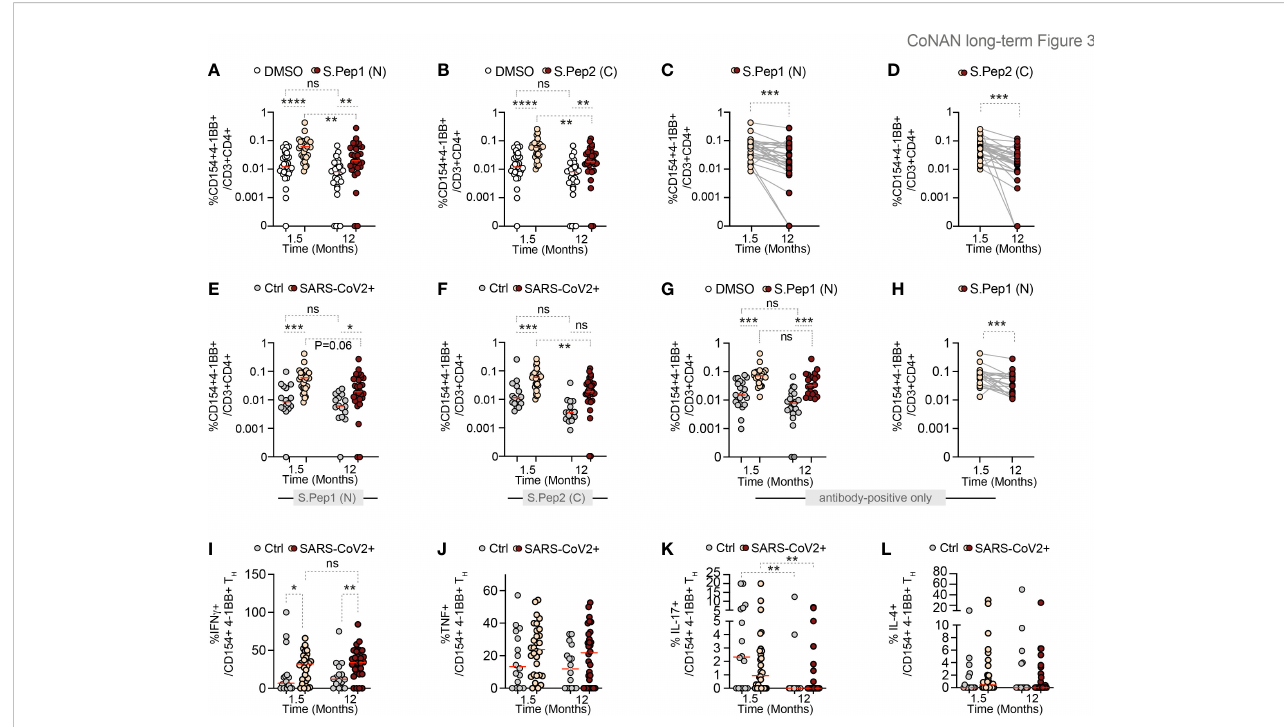
FIGURE 3 Longitudinal SARS-CoV-2 – speci fi c T H cell response. (A) % CD154 + 4-1BB + T H cells from previously infected participants stimulated with DMSO or S.Pep.1 (N-terminal). (B) % of 154 + 4-1BB+ T H cells stimulated with DMSO or S.Pep.2 (C-terminal). ( C, D ) Time course of SARS-CoV-2 – speci fi c T H cells stimulated with (C) S.Pep.1 (N) and (D) S.Pep.2 (C) . ( E, F ) % CD154 + 4-1BB + T H cells stimulated with (E) S.Pep.1 (N) and (F) S.Pep.2 (C) in SARS-CoV-2 negative (Ctrl) versus positive (SARS-CoV-2+) participants. ( G, H ) % CD154 + 4-1BB + T H cells in a subset of antibody positive participants only. (I – L) Positive CD154 + 4-1BB + T H after stimulation with S.Pep.1 for the cytokines (I) IFN g , (J) TNF, (K) IL -17, and (L) IL-4. Dots represent individual participants. Red line indicates median. Time indicates months after the SARS-CoV-2 outbreak. Wilcoxon-matched-pairs test for two matched groups and Kruskal – Wallis with Dunns post-hoc for other analysis with more than two groups.). * p < 0.05; ** p < 0.01; *** p < 0.001; **** p < 0.0001. AB, antibody; Ctrl, controls (non-infected participants); DMSO, dimethyl sulfoxide; IL, Interleukin; IFN, Interferon; ns, non-signi fi cant ( p ≥